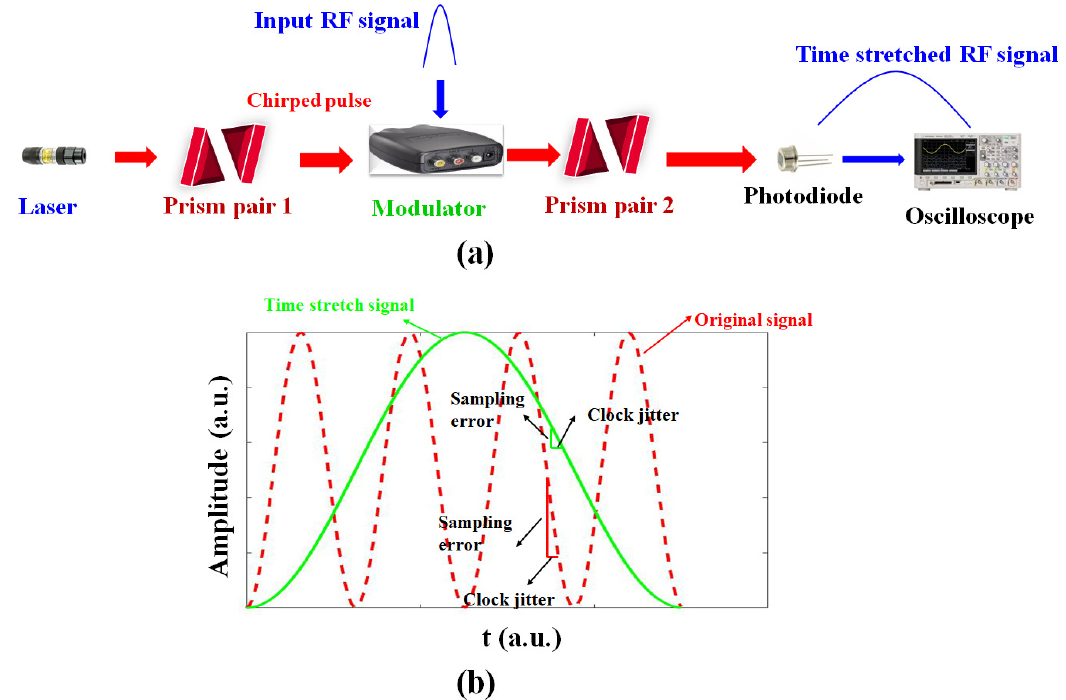
Figure 9. Conceptual diagram of the PTS applied in fast ADCs: ( a ) Schematic layout for the PTS preprocessor; and ( b ) comparison of sampling a signal with and without PTS. The red dotted line and blue solid line represent the original signal and signal after time-stretching, respectively. The prism pair is composed of Ge